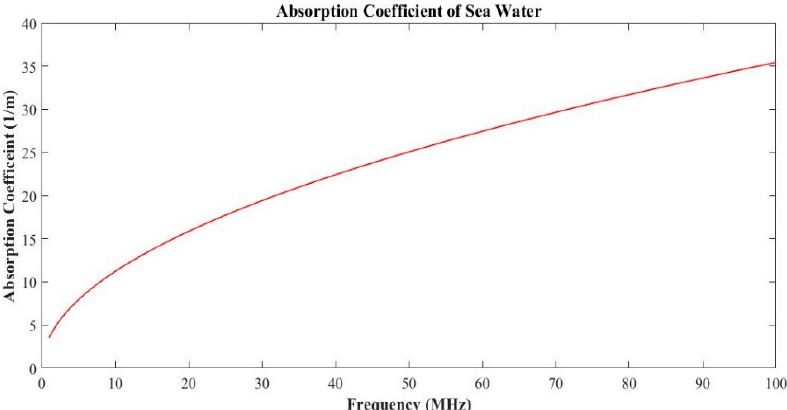
Figure 7. The absorption coe ffi cient of seawater using electromagnetic wireless communication.